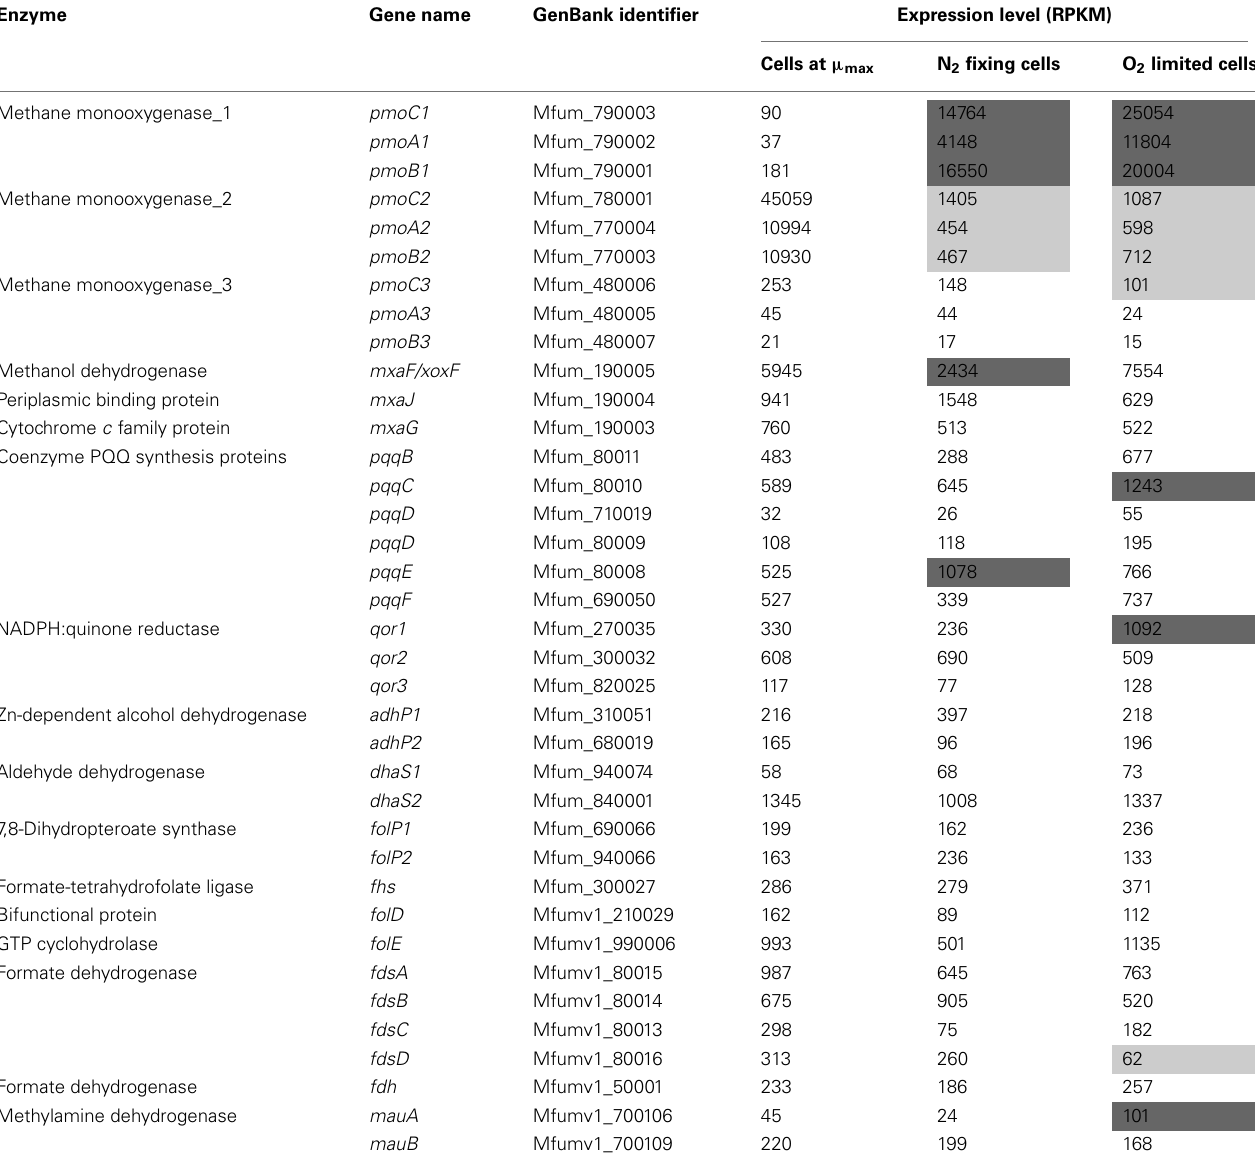
Table 2 |Transcription of genes involved in oxidation of CH 4 in “ Ca. M. fumariolicum ” strain